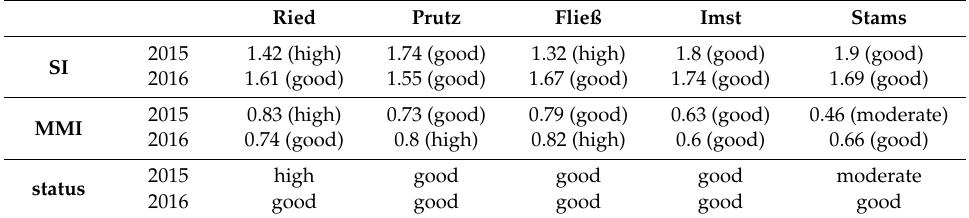
Table 1. Ecoprof result of the detailed MZB-method; modules organic pollution (saprobic index, SI), general degradation (multi-metric index, MMI) and the derived ecological status (status).